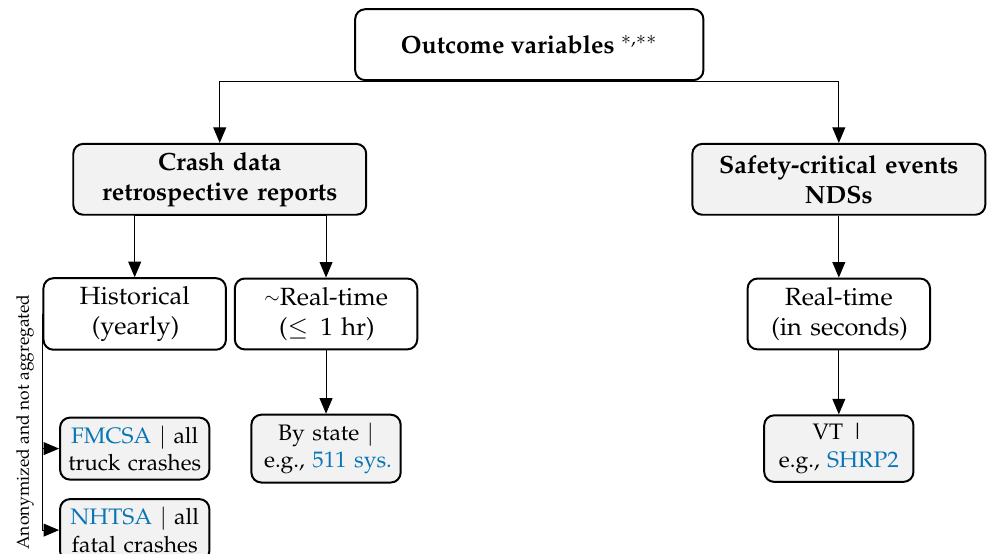
Figure 2. A hierarchical view of outcome variables in crash risk modeling studies. The first level captures the data type, the second level shows the frequency, and the third level highlights examples and sources. * Acronyms: FMCSA = Federal Motor Carrier Safety Administration, NHTSA = National Highway Traffic Safety Administration, VT = Virginia Tech. ** Code: To simplify the data collection process, we present the R code needed to scrape and clean these different data sources at: